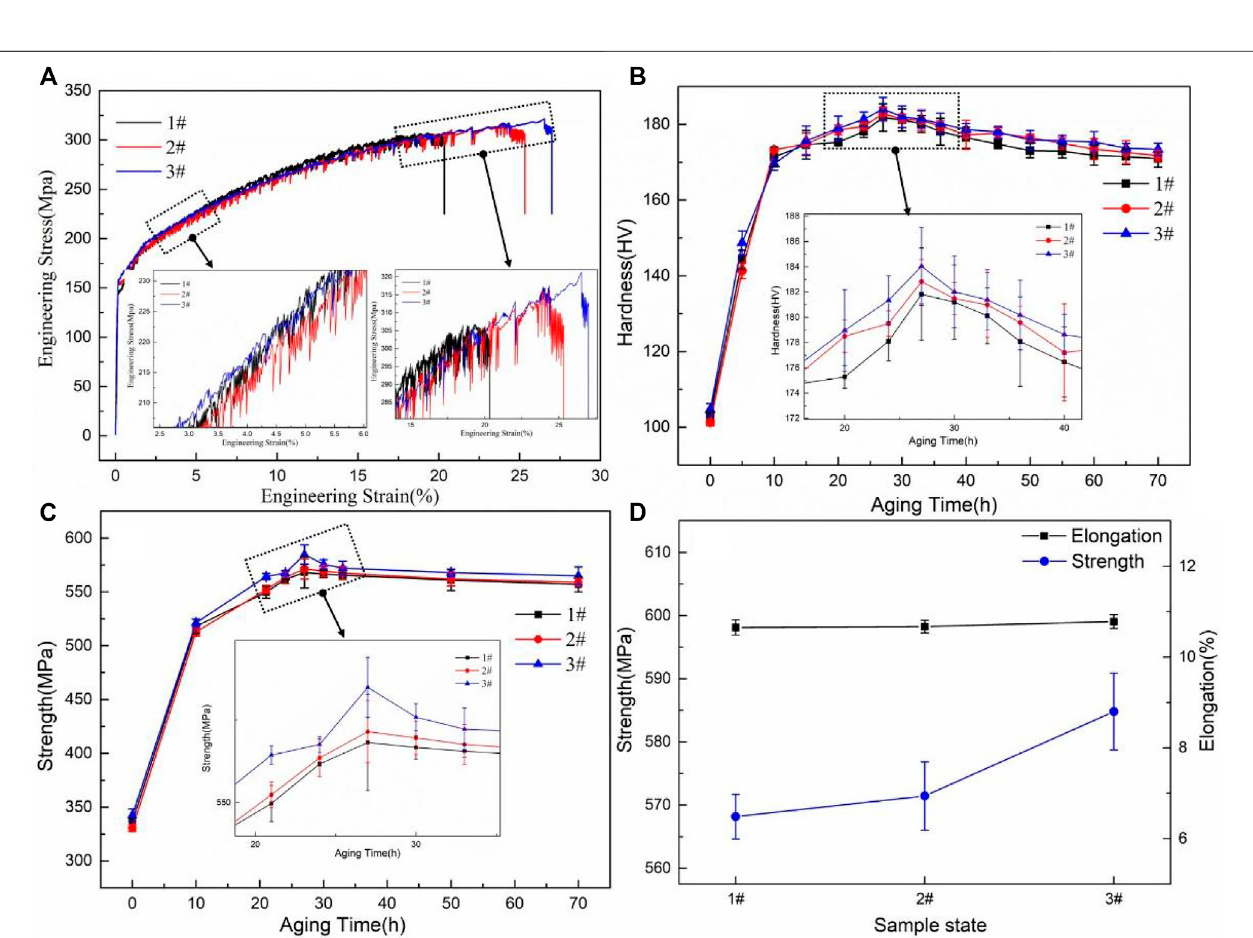
FIGURE 6 | Mechanical properties of specimens after annealing and at T83. (A) stress — strain curves of specimens after annealing, (B) age hardening curve, (C) aging strength curve, (D) Mechanical properties of sample at T83 after removing coarse-grained layer.